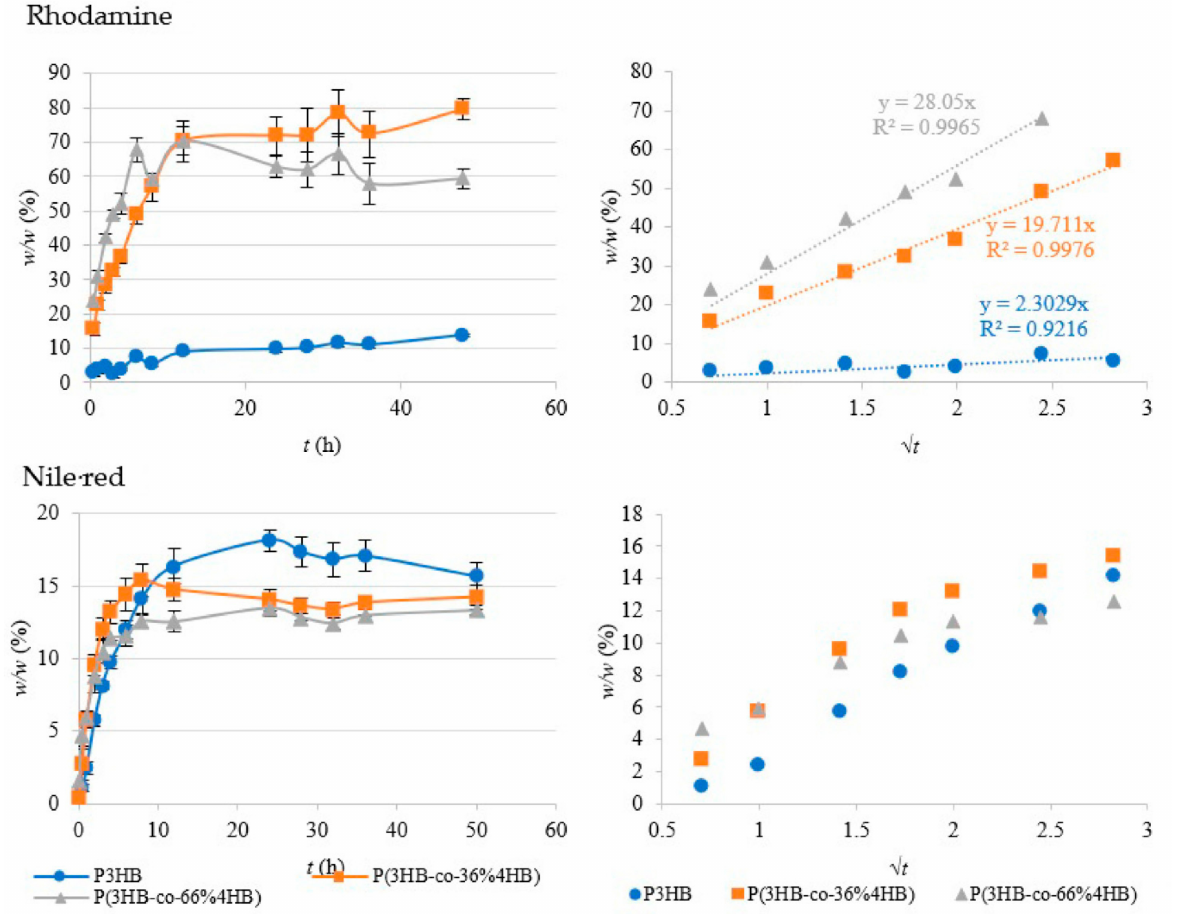
Figure 6. Results from active ingredients release tests highlighting the differences in rhodamine and Nile red release from the homopolymer P3HB and the P(3HB- co -4HB)